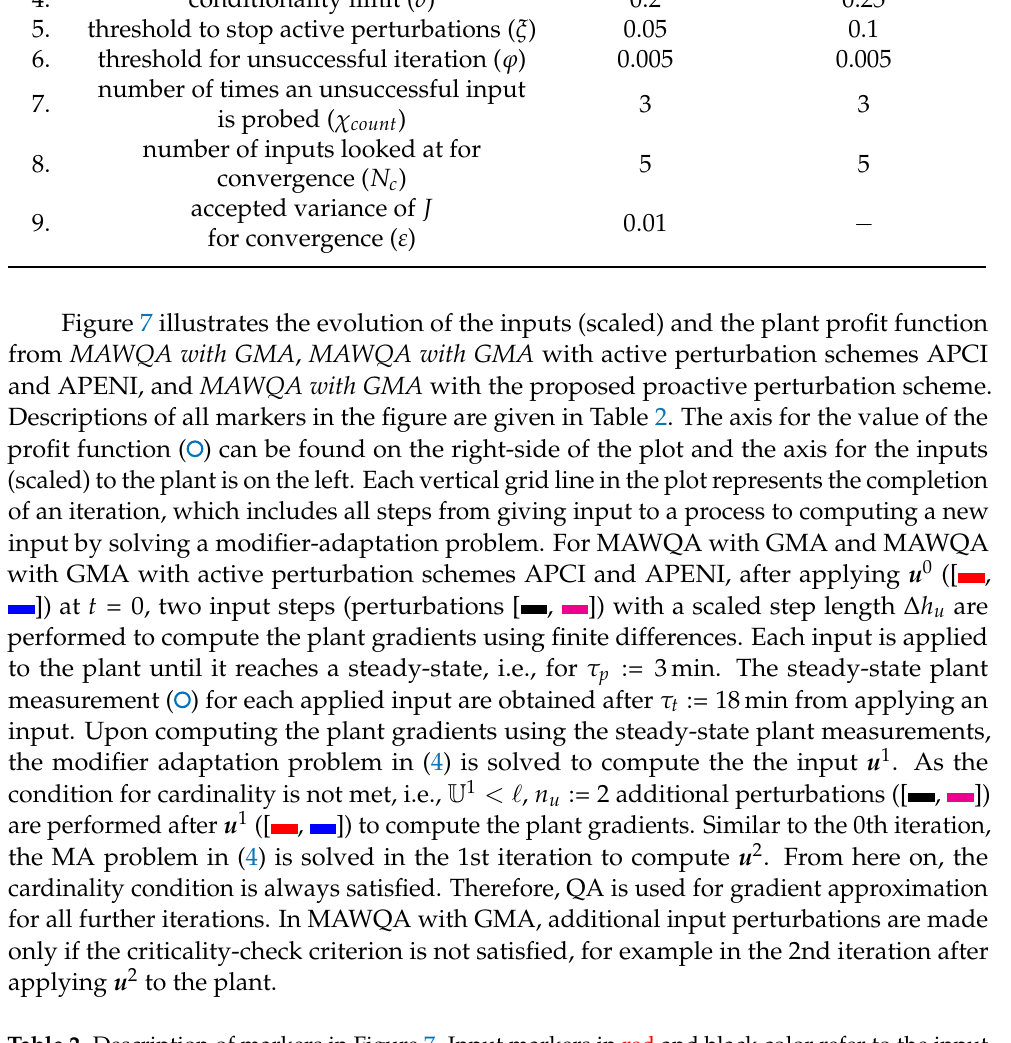
Table 2. Description of markers in Figure 7. Input markers in red and black color refer to the input variable u 1 ; blue and magenta input markers refer to the input variable u 2